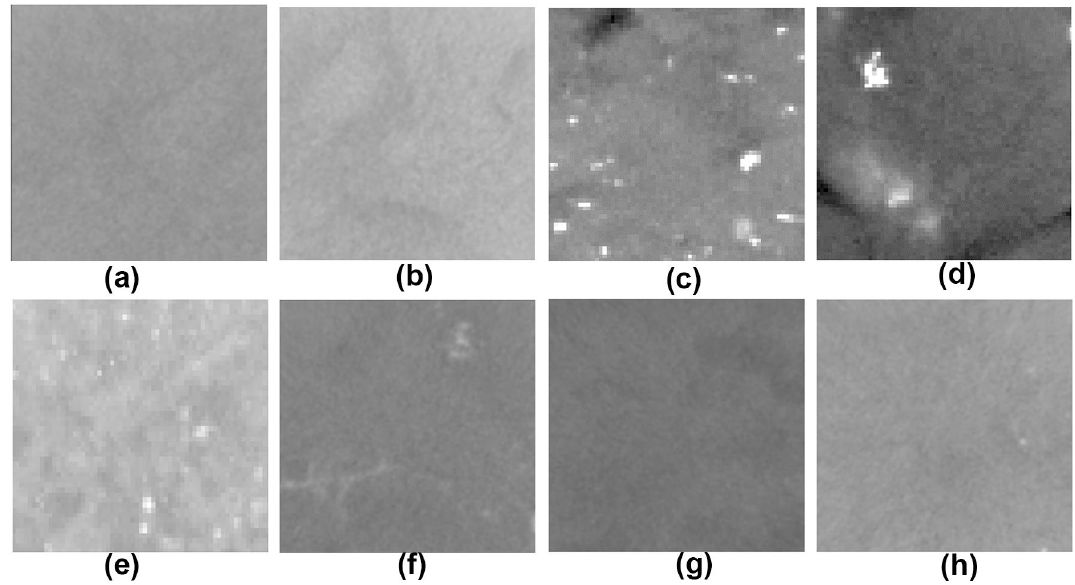
Mudstone, d Mudstone with high-density minerals, e Cemented very fine-grained sandstone, f Massive very fine-grained green sandstone, g Muddy fine-grained sandstone, h Continental mud- stone. The size of images is 64 × 64 pixels